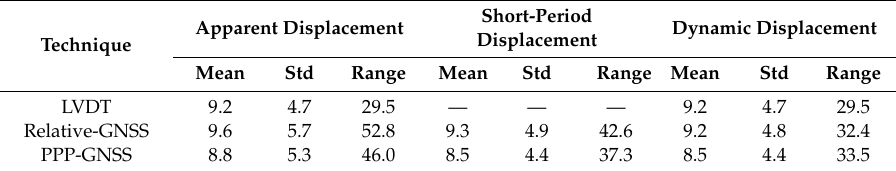
Table 1. Statistical analysis of the development model (unit: